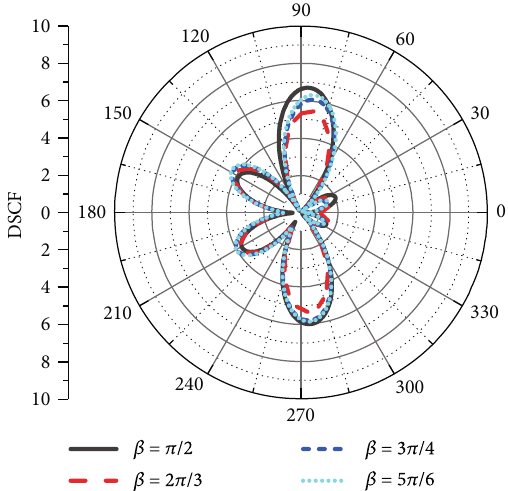
Figure 14: DSCF distribution of the circular hole for di ff erent values of β ( r / r 2 = 2 : 0